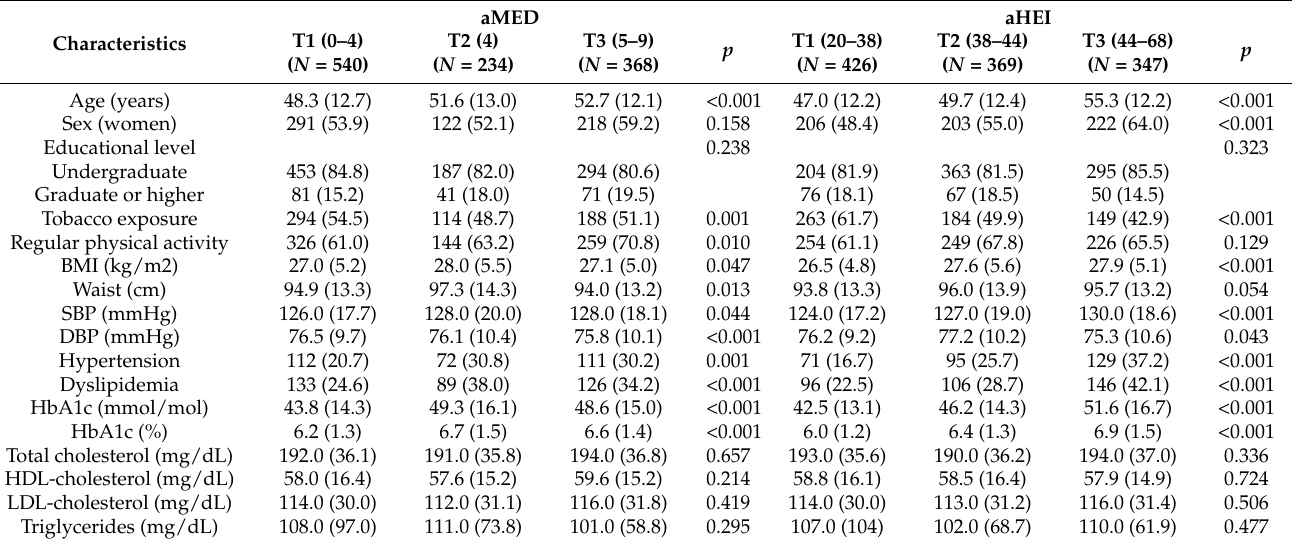
Table 1. Clinical characteristics according to adherence to the diet assessed using dietary quality indexes.